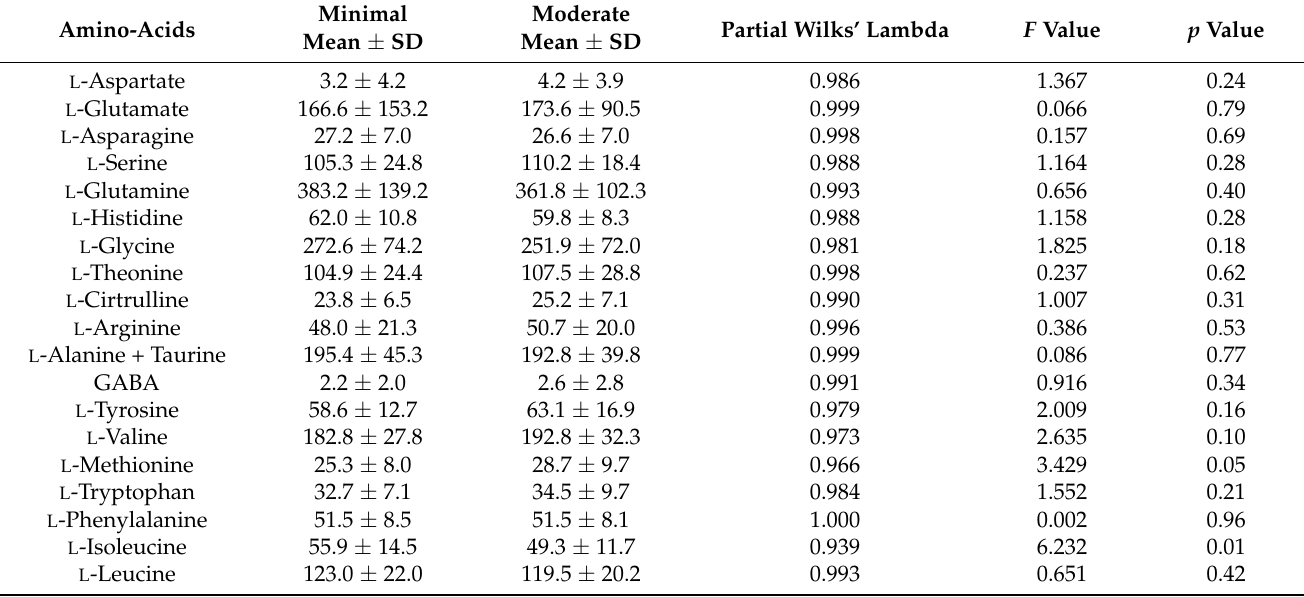
Table 2. Amino-acid profiles ( µ M) of the elderly women with minimal and moderate depressive symptoms.